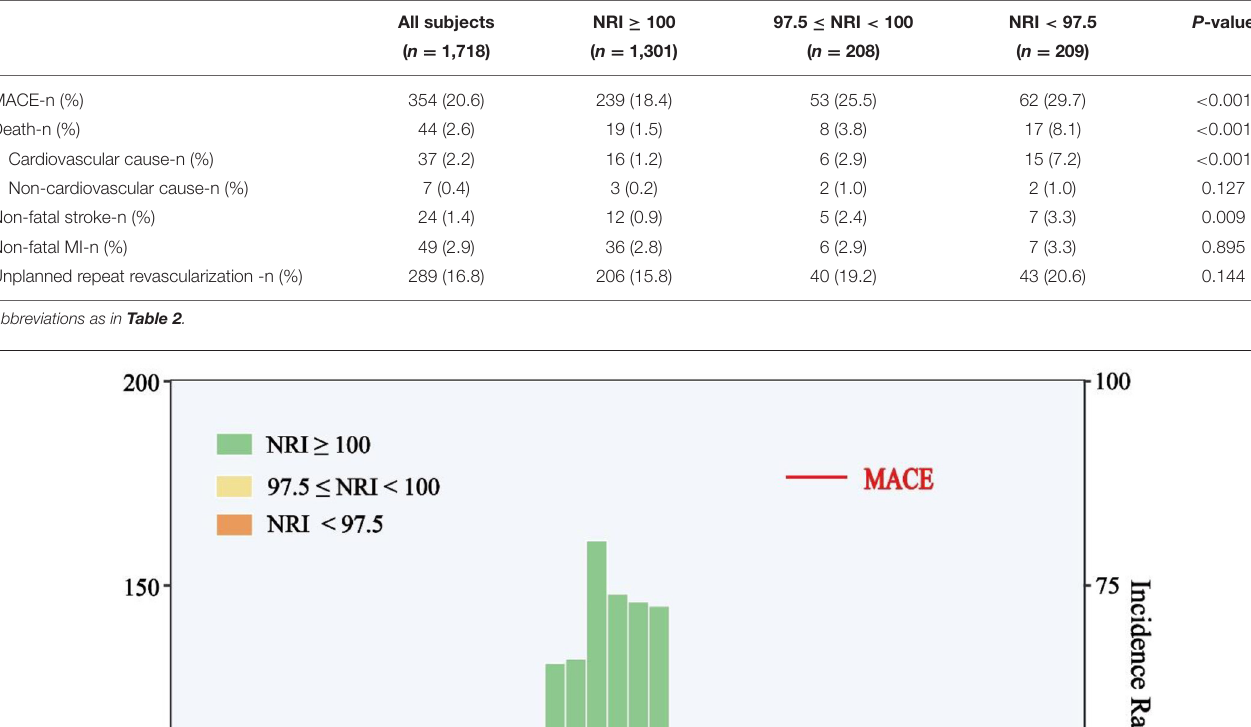
and moderate-to-severe group [HR for mild and moderate- to-severe nutritional risk respectively: 1.368 (95%CI 1.004– 1.871) and 1.473 (95%CI 1.064–2.041)] ( Table 3 ). When